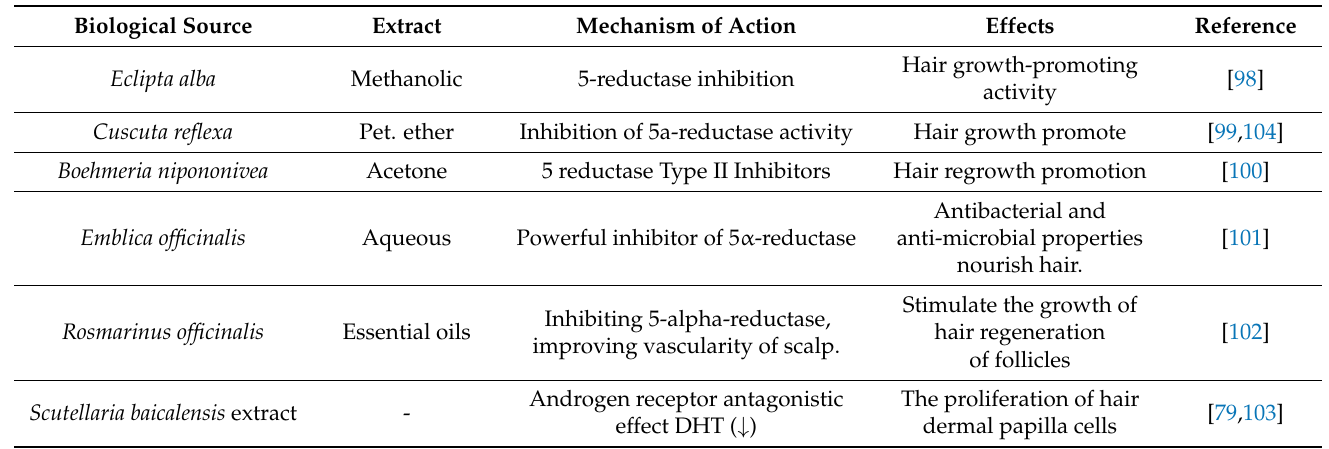
Figure 6. Herbal medicines acting on DHT and 5 α -reductase. Table 5. Herbal medicines act on DHT and 5 α